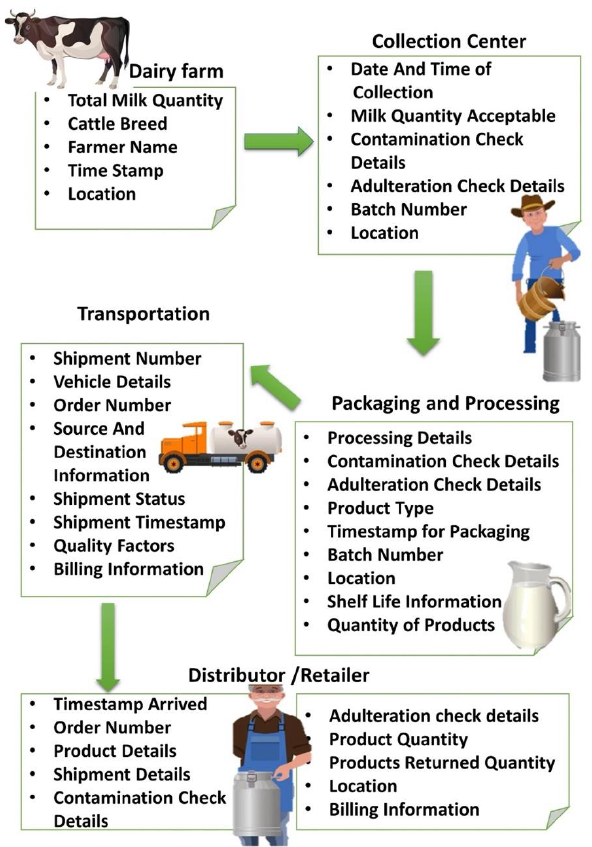
Figure 5. Information exchange within the food safety and traceability platform.